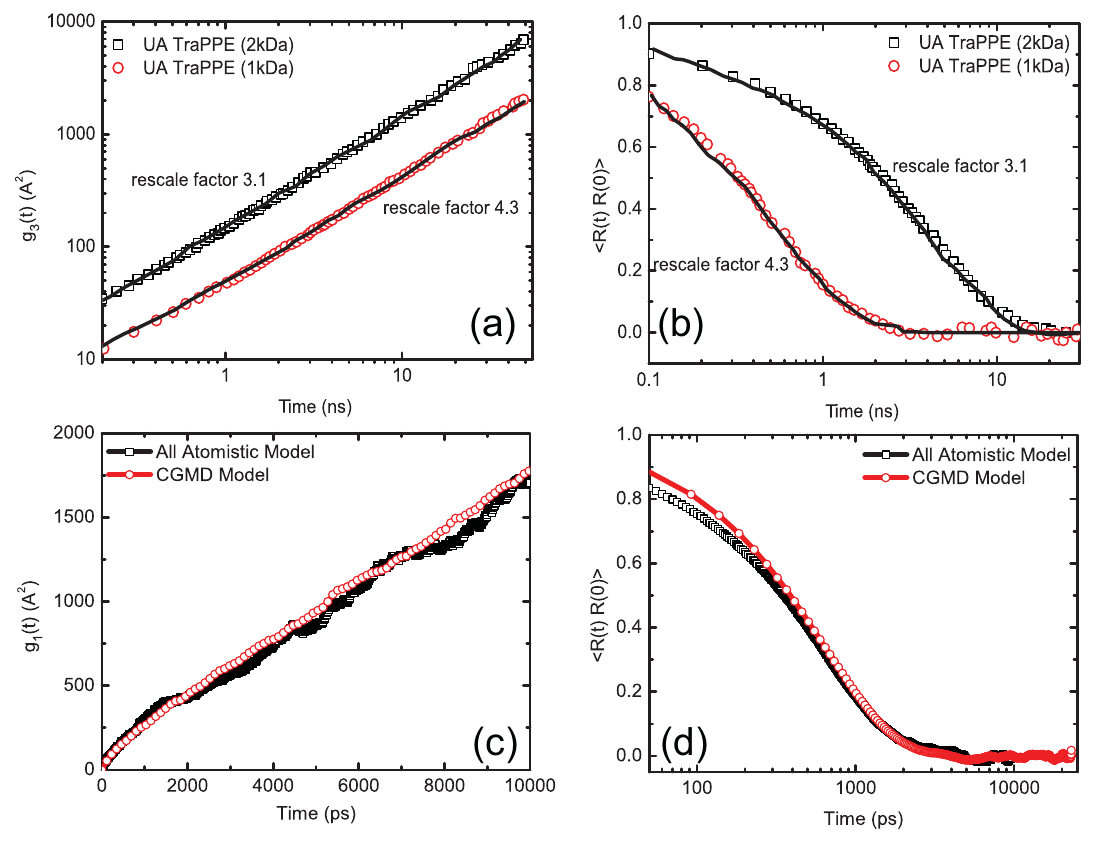
Figure 12. ( a ) Autocorrelation function of end-to-end unit vector, (cid:104) R ( t ) · R (0) (cid:105) , and ( b ) ( t ) versus time for both united-atom (dots) and coarse-grained mean-squared displacement g 3 (lines) PS melts at 463 K; ( c ) (cid:104) R ( t ) · R (0) (cid:105) and ( d ) mean-squared displacement, g versus time for both all-atomistic and coarse-grained cis-PI melts at 413 K. The time of the coarse-grained simulation has been rescaled by a factor of 11.47 in ( c ) and ( d ). Figures reproduced with permission from